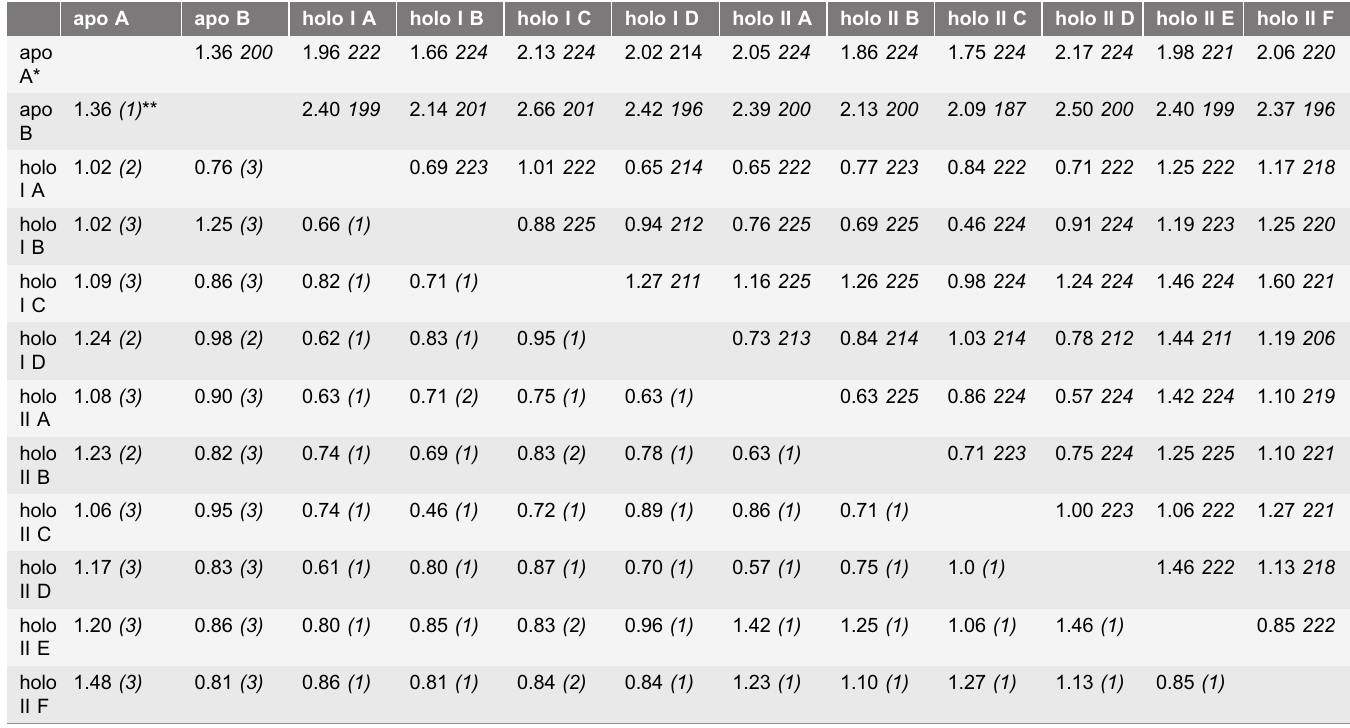
Table 2. Comparison of holo and cAMP bound Cg-GlxR in crystal form I and II. apo